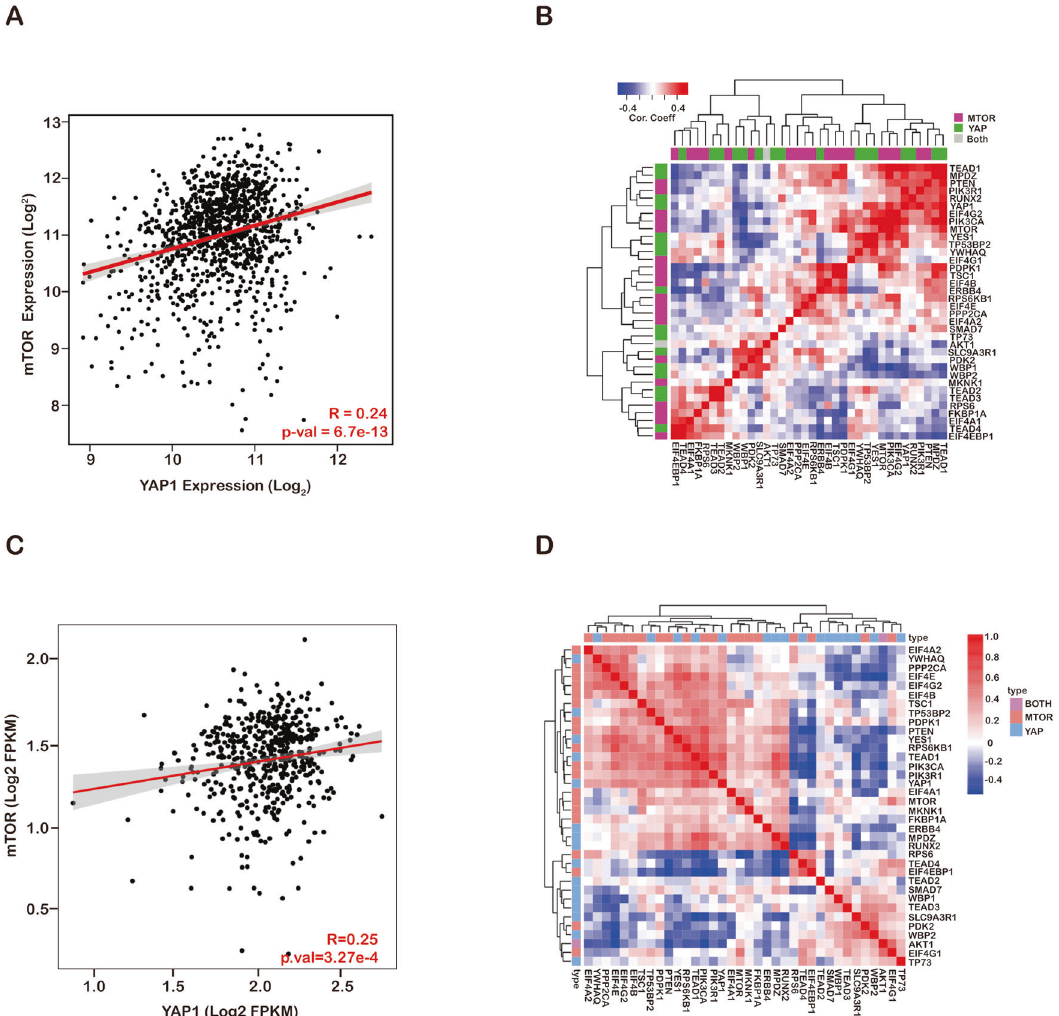
Fig. 1 Coactivation of the Hippo and mTOR pathways in cancer. a Pearson ’ s correlation analysis comparing the expression of YAP1 and mTOR in TCGA database breast cancer tissues and Fisher ’ s exact test. b Pearson ’ s correlation analysis comparing mTOR pathway factors and the expression of YAP target genes in TCGA database breast cancer tissues, Fisher ’ s exact test. c Pearson ’ s correlation analysis comparing the expression of YAP1 and mTOR in TCGA database colon cancer tissues and Fisher ’ s exact test. d Pearson ’ s correlation analysis comparing the mTOR pathway factors and YAP target gene expression in TCGA database colon cancer tissues and Fisher ’ s exact